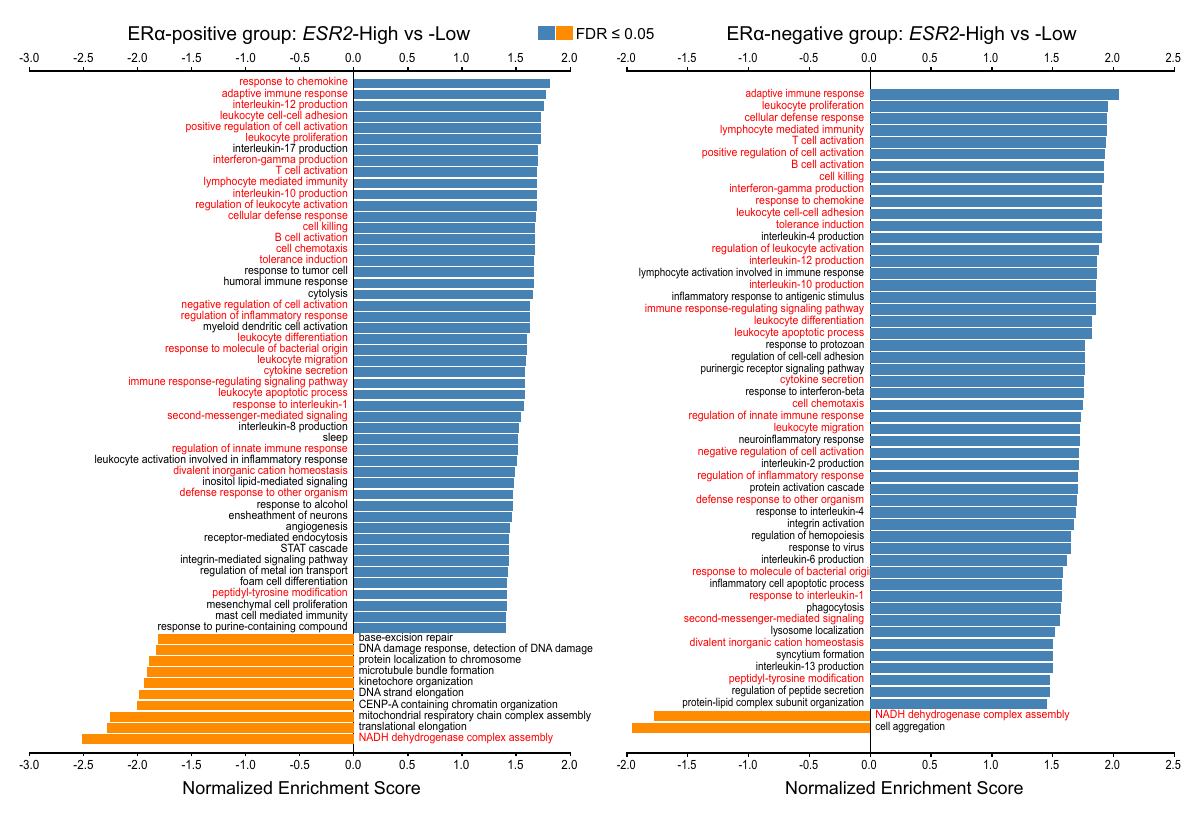
Figure 6. Gene Set Enrichment Analysis (GSEA; GO category: Biological Process) of genes ranked by fold change (log 2 FC) and p-value < 0.05, associated with ESR2 -high vs -low in SCAN-B. GSEA analysis based on ESR2 -high vs -low was performed separately for the ERα-positive ( A ) and ERα-negative ( B ) subgroups. Categories found enriched in both subgroup analyses are indicated by red